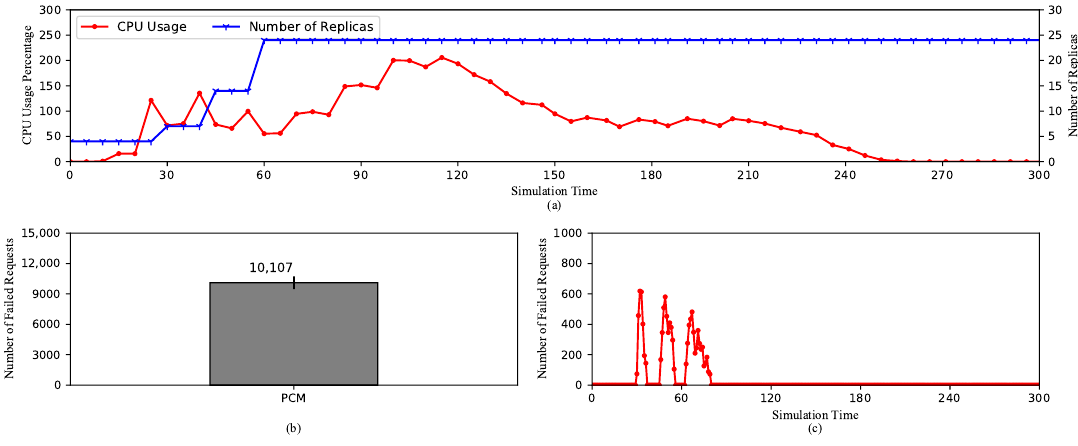
Figure 5. HPA using Prometheus Custom Metrics (PCM). ( a ) The average CPU usage and the scaling of the replica set. ( b ) The total number of the failed requests. ( c ) The timeline of the failed